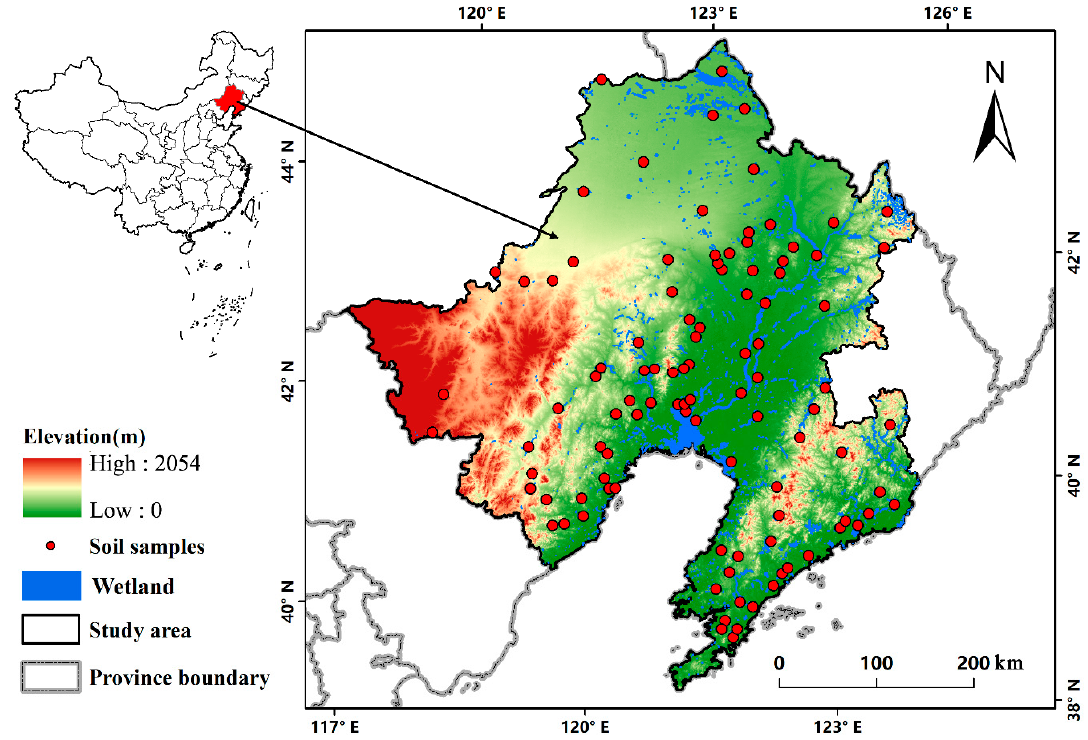
Figure 1. Location of the Liao River Basin (LRB) in China and the distribution of wetland and soil samples in the study area.